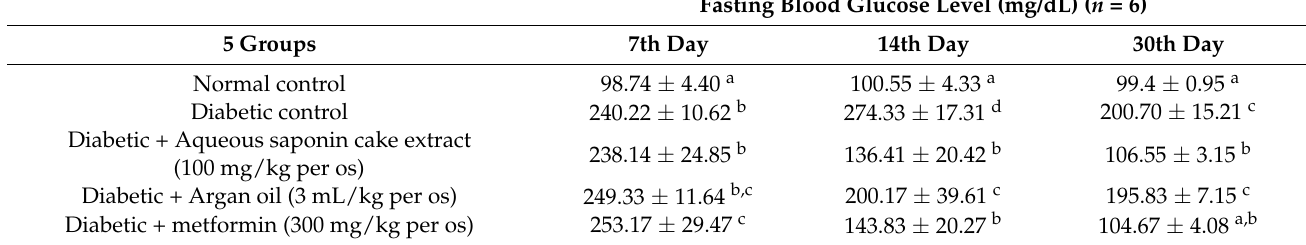
Table 4. The effects of aqueous saponin Argan cake extract and Argan oil on fasting blood glucose levels in alloxan-induced diabetic mice.